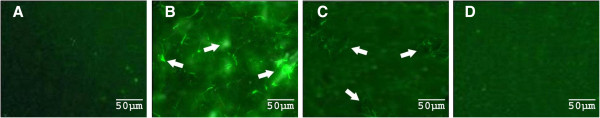
Depict the immunofluorescent pattern of GFAP positive cells in striatum and midbrain respectively, exhibiting markedly increased, ramified form with many fine processes in MPTP treated mice. GFAP immunoreactivity was mild in the striatum and midbrain of control (Group I) and AS treated mice (Group III). Immunoflurosence expression of GFAP in mid brian tissue. A: Control (group 1); B: MPTP induced (group II); C: MPTP induced + As treated (group III); D: Drug Control (group IV).